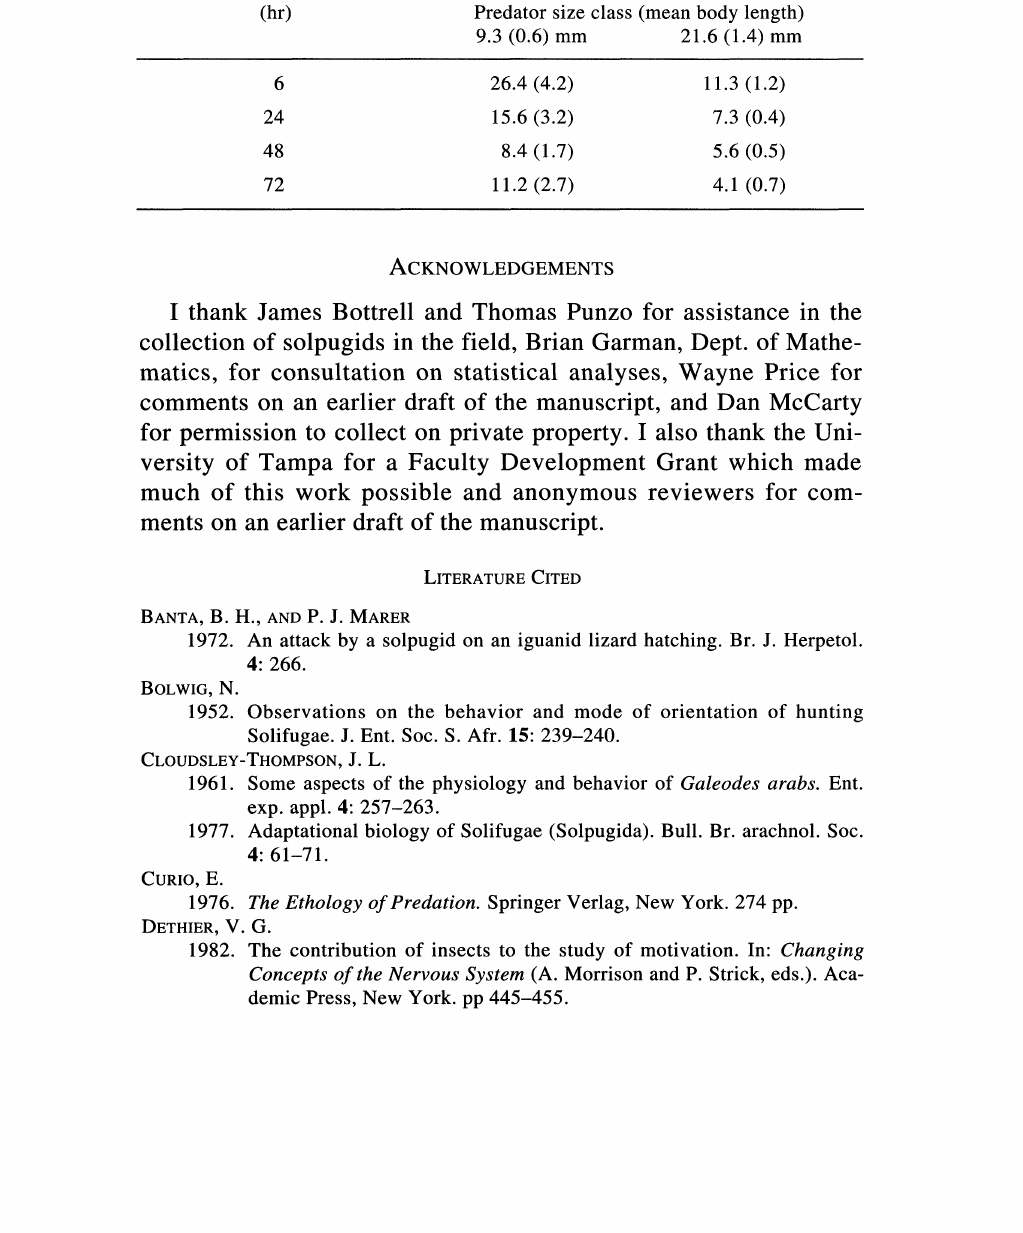
Table 4. The effect of food deprivation (hr) and predator size on the amount of time (min) required for Eremobates palpisetulosus females to ingest a single cricket weighing 0.3 +_ 0.05 g. Values represent means (_+ S.D.) for 15 solpugids in each size class. Food